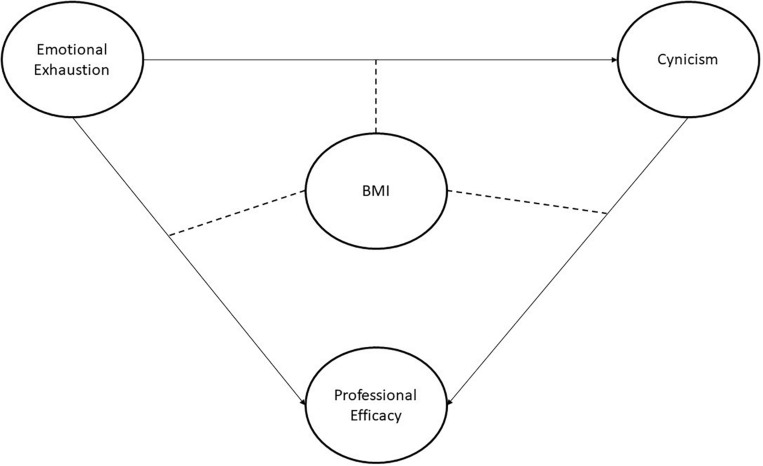
Hypothetical model.